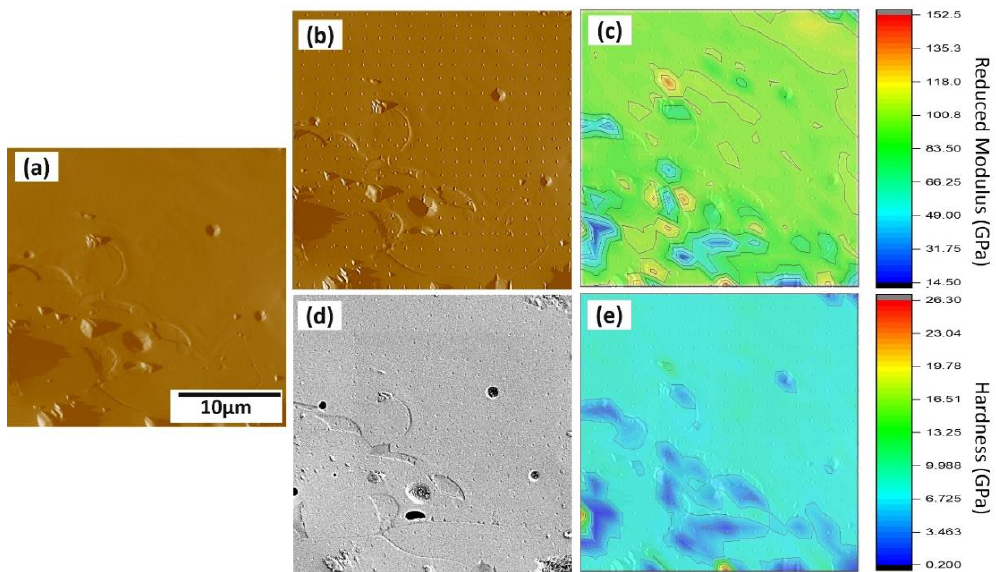
Figure 7. Results of the nanoindentation test of the Sr–HT–G coating. ( a ) The SPM image of surface before applying the indents; ( b ) and ( d ) the SPM and SEM image of surface after applying the indents; ( c ) and ( e ) property map of reduced modulus and hardness of the coating.